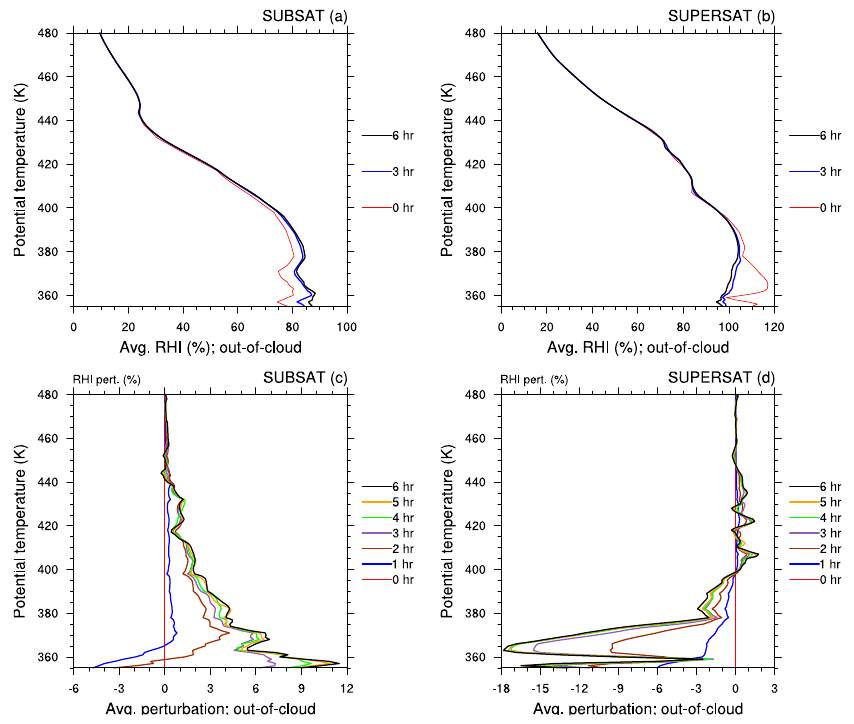
Fig. 6. Mean out-of-cloud RHI profiles at model times t = 0, 3 and 6h for (a) SUBSAT and (b) SUPERSAT. The out-of-cloud RHI perturba- tions from the initial value for (c) SUBSAT and (d) SUPERSAT are also